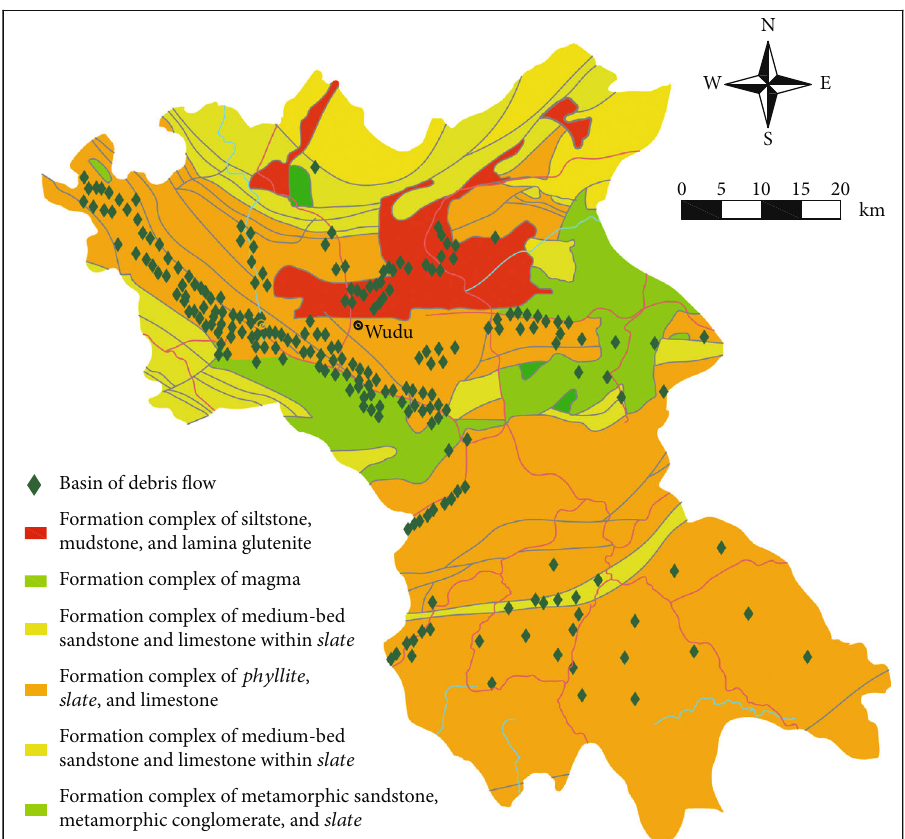
Figure 1: The sampling areas on a map of Wudu and representative debris fl ow gully.